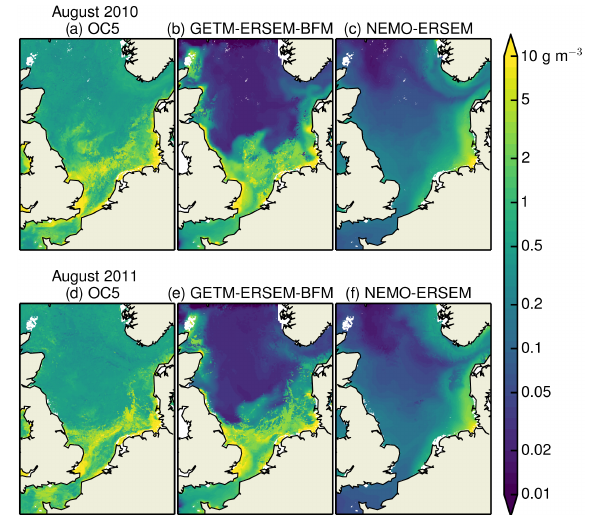
Figure 8. Composites of sea surface SPM at ocean colour obser- vation points for August 2010 (a–c) and August 2011 (d–f) : satel- lite observations (a, d) , GETM-ERSEM-BFM (b, e) , and NEMO- ERSEM (c, f)